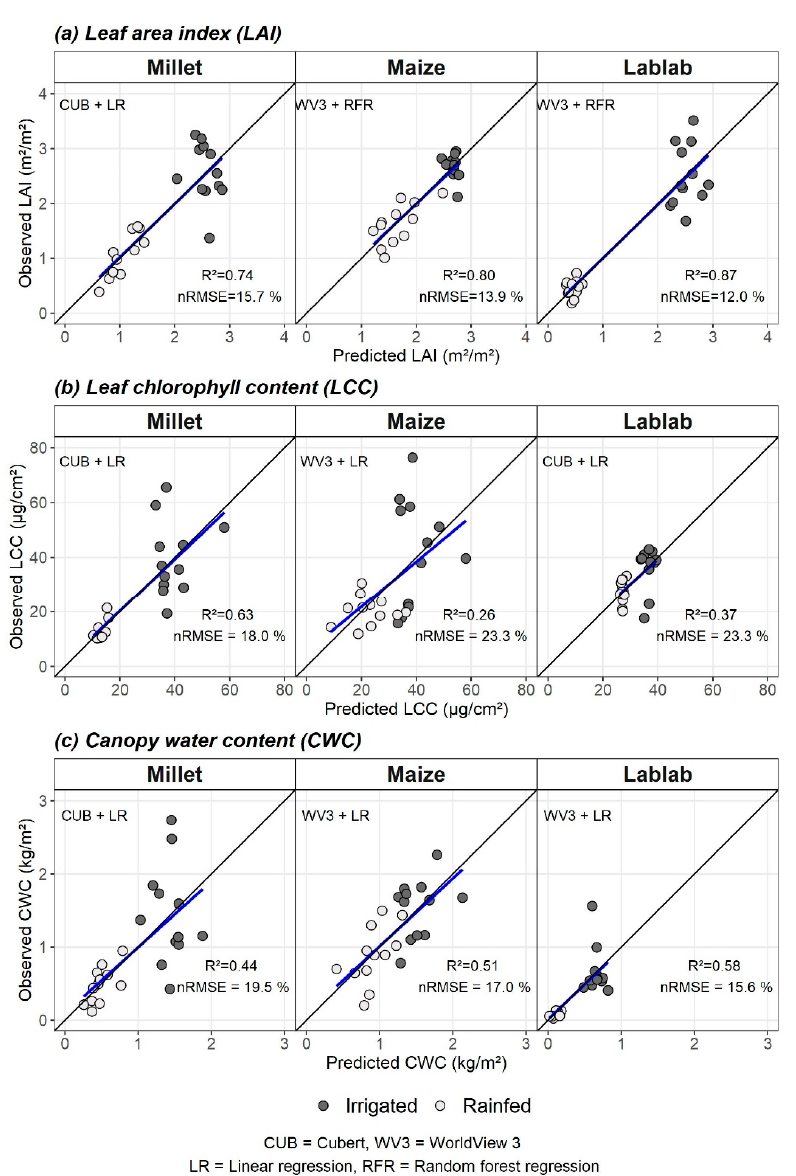
Figure 4. Observed vs predicted values of the best performing models for ( a ) leaf area index (LAI), ( b ) leaf chlorophyll content (LCC), and ( c ) canopy water content (CWC). The remote sensing data type (CUB or WV3) and modelling method (LR or RFR) for the best models are indicated as “RS data type + modelling method” (e.g., CUB + LR). The blue line is the fitted regression line between predicted and observed values, and the black line is the 1:1 line.